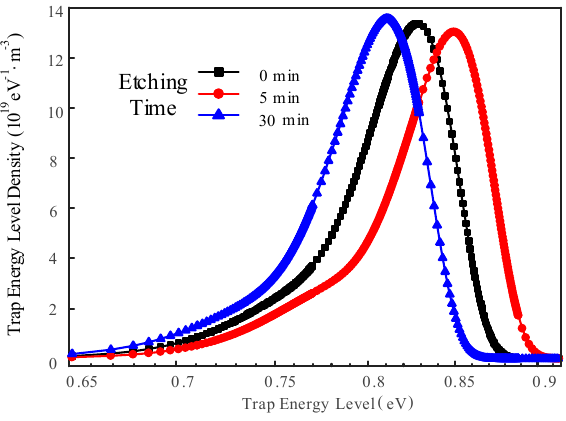
Figure 6. Trap energy distribution characteristics of samples with di ff erent etching times.